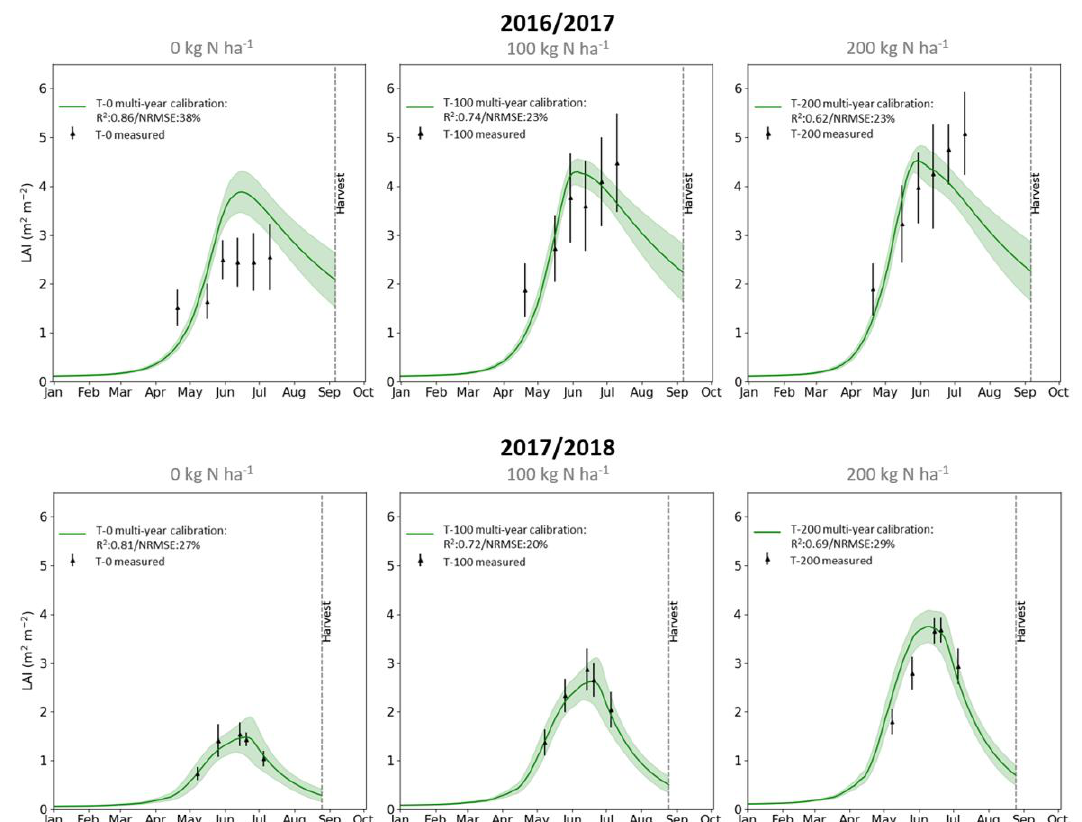
Figure 4. Time-series validation plots comparing DALEC-Crop LAI estimates for the cross-treatment and multi-year parameter calibrations compared to observations (black error bars) for the 2016–2017 (top row) and 2017–2018 (bottom row) winter wheat growing seasons. Plots shown for the 0 kg N ha − 1 (T-0; left column), 100 kg N ha − 1 (T-100; middle column) and 200 kg N ha − 1 (T-200; right column) fertilizer treatments. Standard deviation of the LAI values is shown for the observations and modelled estimates (green shading). Table 3. Summary validation statistics comparing DALEC-Crop LAI estimates for each nitrogen (N) fertilizer treatment derived from the multi-year single model calibration for the 2016 – 2017 and